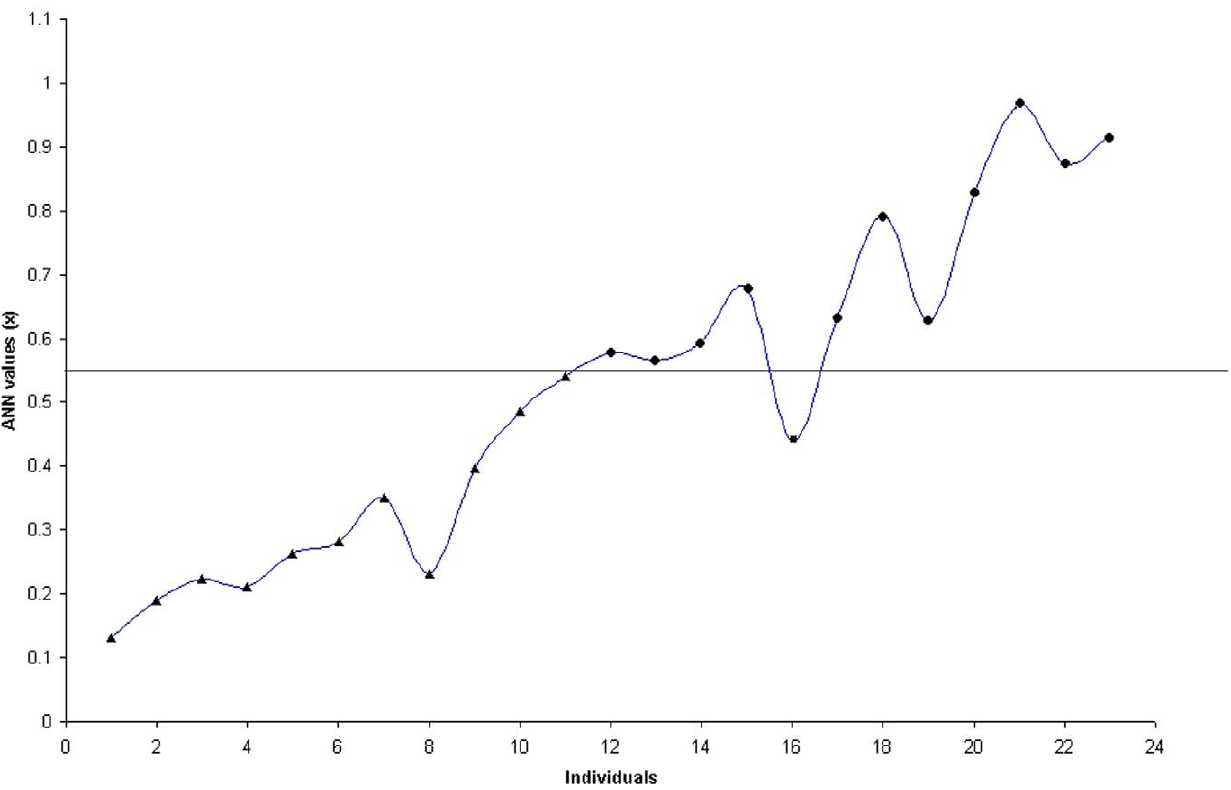
Figure 4. Neural network predication. Neural network classification of 23 individuals (x-axis) with known clinical information. Values (y-axis) are predicted over the trained network and are 0.1 to 1; values (x) # 0.54 reflect a neural-network classification of ‘‘normal,’’ and values (x) $ 0.55 reflect a